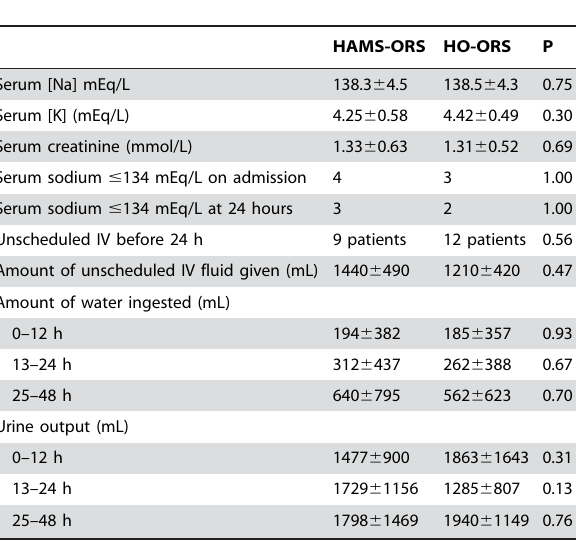
Values shown are absolute numbers of patients or mean 6 SD.